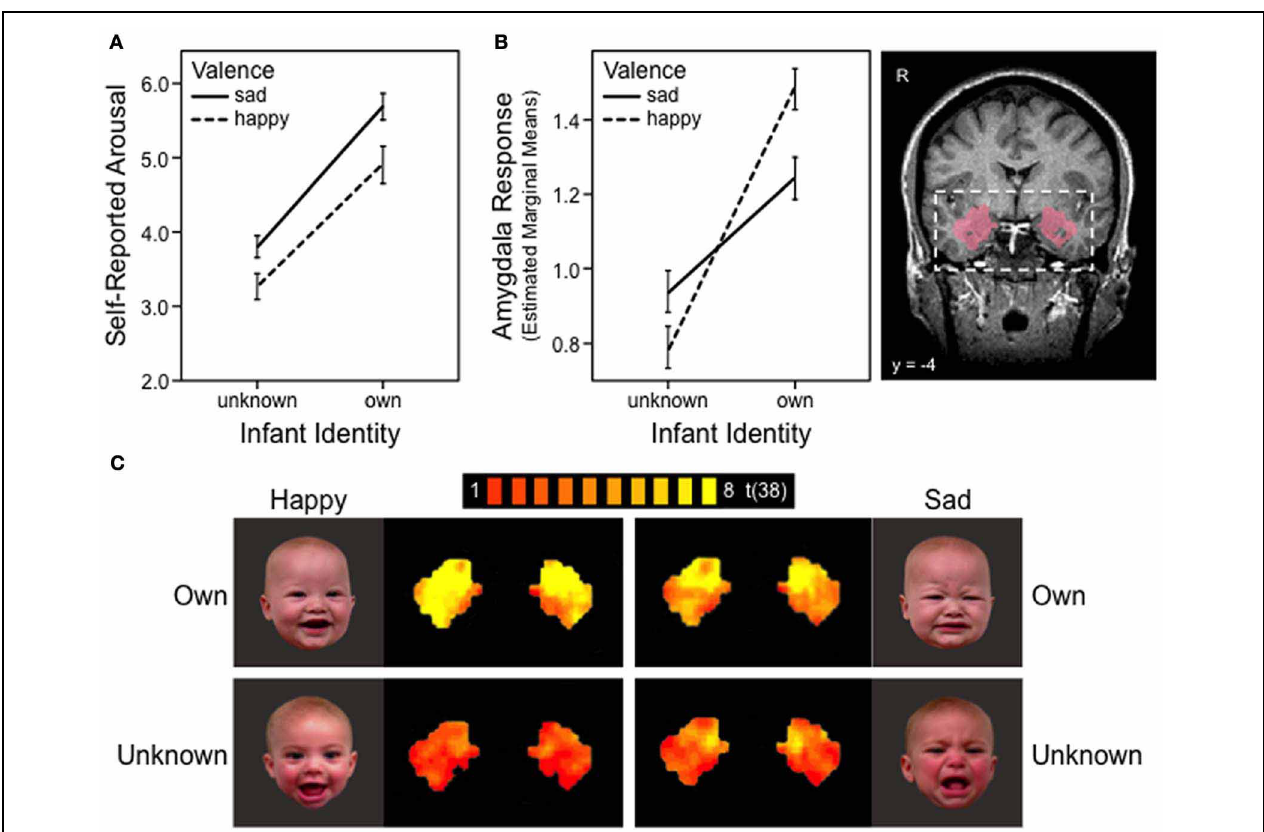
FIGURE 1 | Maternal responses to own and unknown infant face cues, happy vs. sad. (A) Mother’s self-reported emotional arousal, rated using a 9-point Likert scale: 0 = calm and 8 = aroused. Error bars depict standard error of mean. (B) BOLD response in the bilateral amygdala region of interest. Anatomical mask used to define amygdala